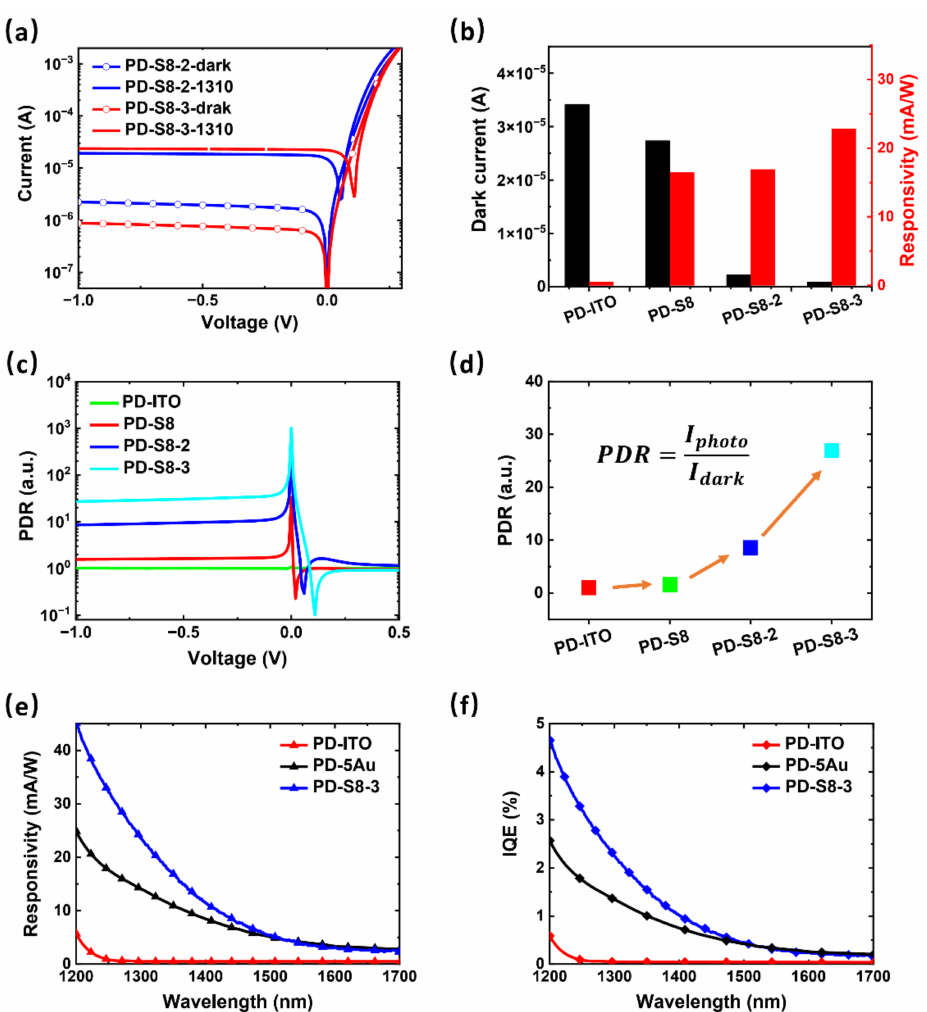
Figure 5. ( a ) The dark currents and photocurrents at 1310 nm of PD-S8-2 and PD-S8-3 from − 1 to 0.3 V. ( b ) The comparison of PDs with different structures in dark current and the responsivity at 1310 nm at − 1 V. ( c ) The PDRs of the PDs at 1310 nm as a function of bias. ( d ) The PDRs of the PDs at 1310 nm for the reverse bias of 1 V. ( e ) The responsivity spectra and ( f ) the internal quantum efficiency (IQE) spectra of PD-ITO, PD-5Au, and